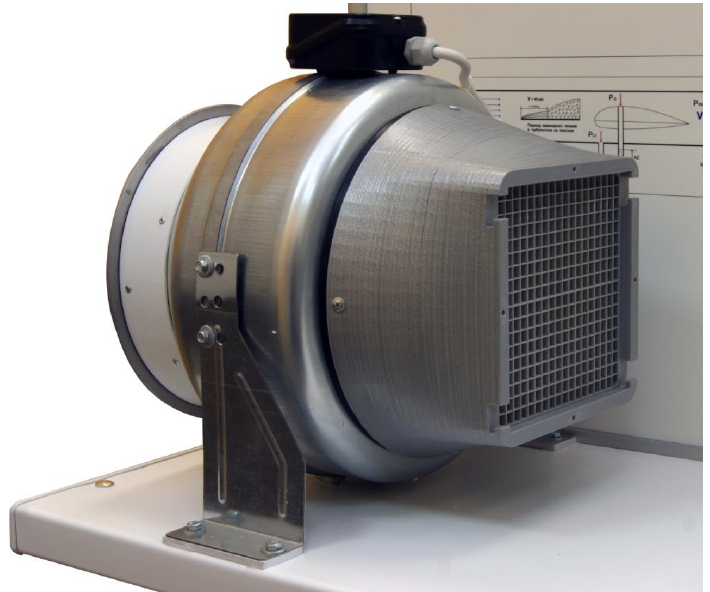
Figure 3. The wind tunnel in which the wind turbine is inserted (the attached device for measuring the pressure drop and temperature is shown above).